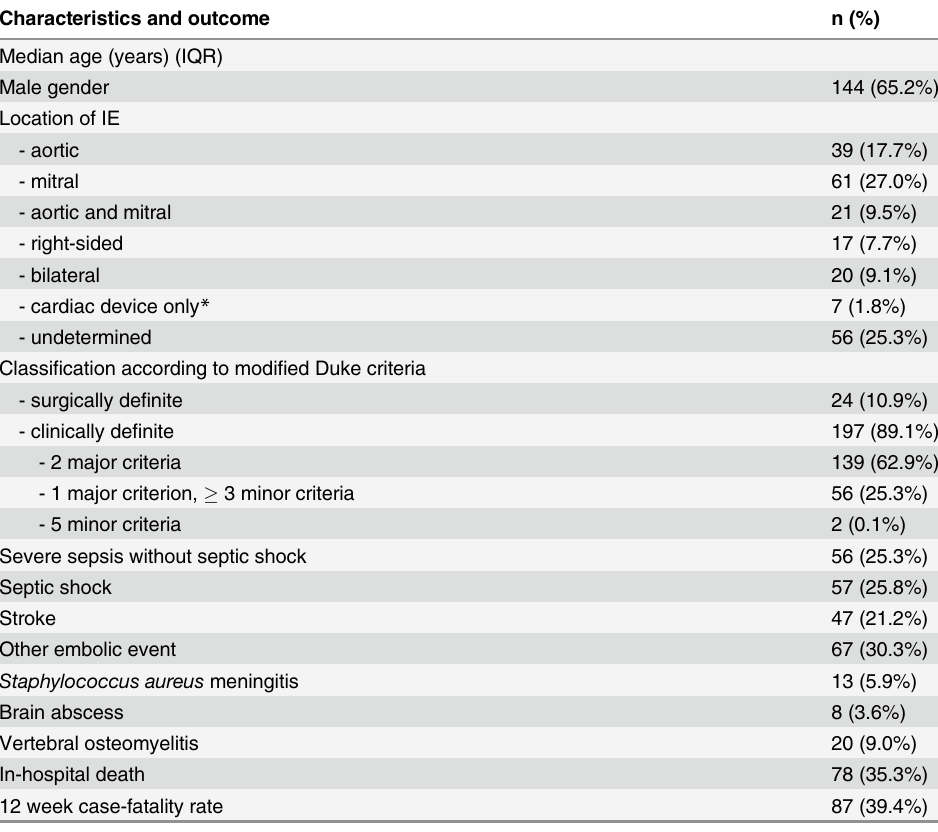
Table 2. Description of the 221 infective endocarditis diagnosed among the 2008 patients enrolled in the VIRSTA study, 2009 – 2011. Characteristics and